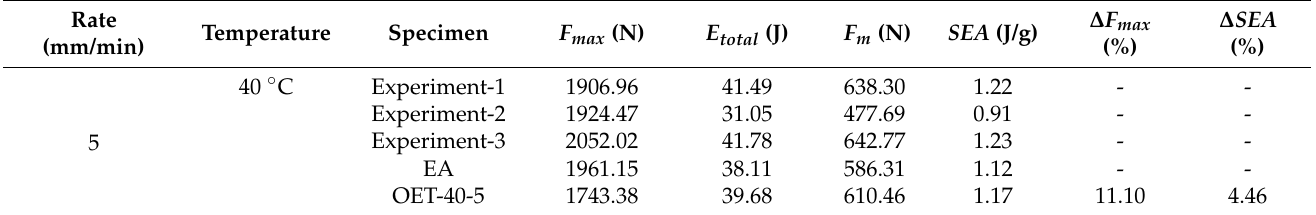
Table 5. The compression rate at 5 mm/min: the energy absorption index of quasi-static uniaxial compression experiment and numerical simulation of OET at 40 ◦